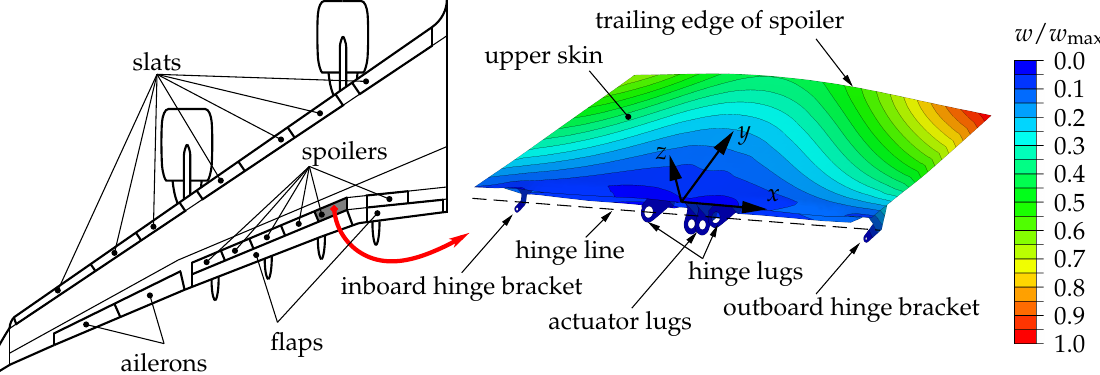
Figure 1. Location and deformation of the considered aircraft spoiler of an Airbus A340 aircraft, overview of control surfaces (cf. [43]), and out-of-plane deformation of the spoiler’s upper skin according to considered load